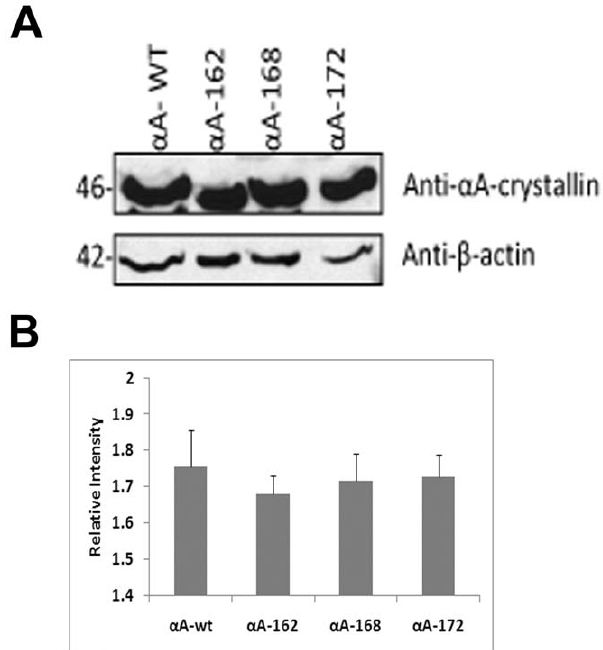
Figure 2. Level of expression of the wild-type and truncated a A-Crystallin constructs in HeLa cells. A: Western blot analysis of individual expression of a A- constructs in HeLa cells . Cells were transfected with a total of 2 m g of YFP a Awt, YFP a A162, YFP a A168 and YFP a A172 constructs. After 48 hours transfection, cells were lysed and subjected to immunoblot and probed with anti- a A-Crystallin antibody. This antibody is specific for a Awt and the truncated a A- crystallins, which recognizes a 46 kDa (the mass of a A-crystallin + YFP) protein. The same blot was stripped and re-probed with anti- b -actin for loading controls. B: Quantitative data for western blot analysis as in Fig. 2A . Quantitation of a A-Crystallin wild-type and truncated constructs normalized against b -Actin was determined with NIH Image J Software. The levels were averaged over three independent experiments and plotted. The values are means 6 Standard